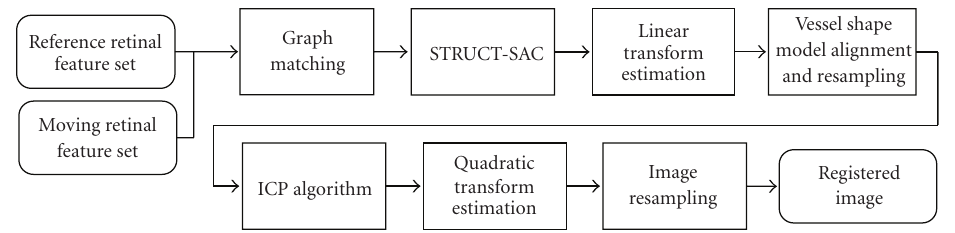
Figure 3: Flowchart of proposed GM-ICP registration algorithm.